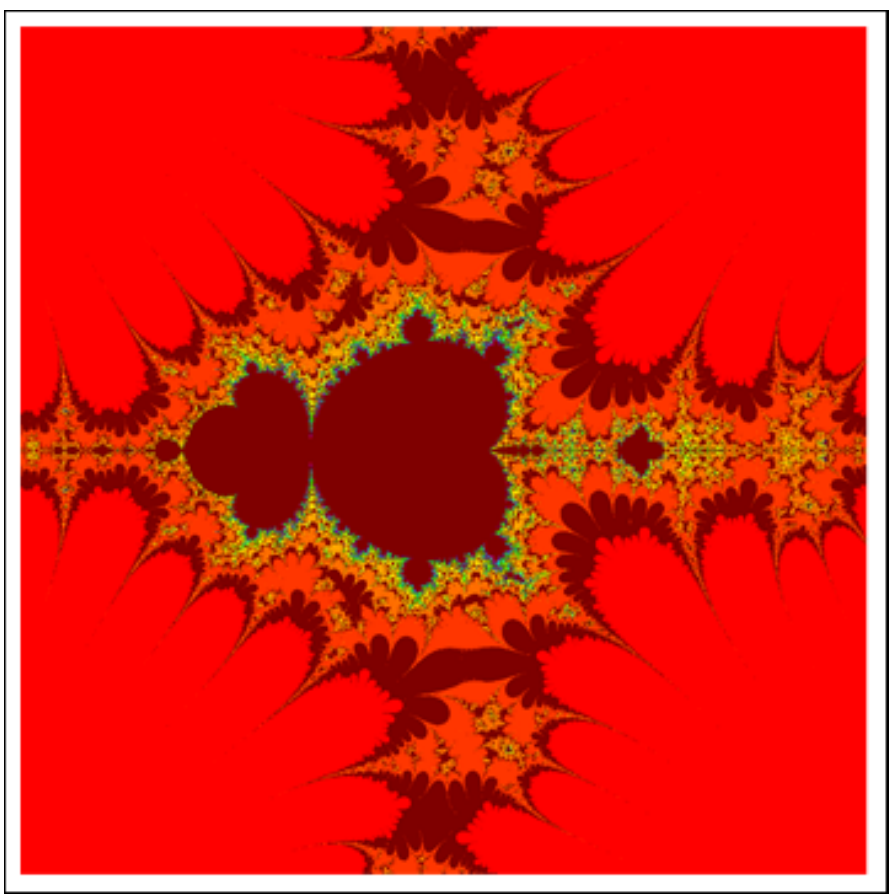
Figure 19. M-set for τ ( z ) = sin ( z 2 ) + c via DKIS. The image execution time is 507.89